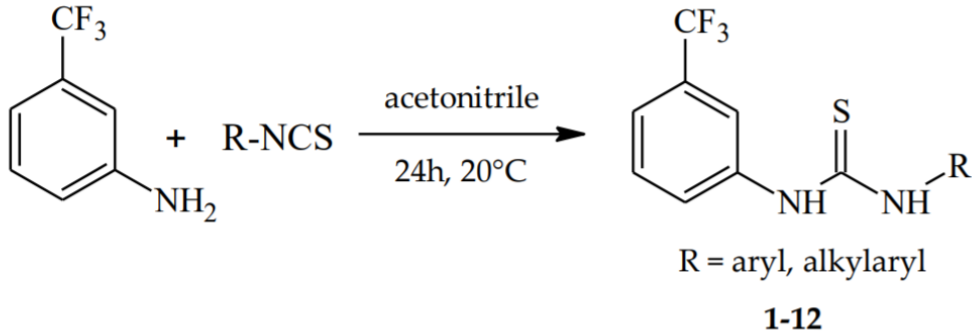
Figure 1. Anticancer agents derived from diaryl(thio)urea and the common scaffold of the designed target 3-(trifluorome-